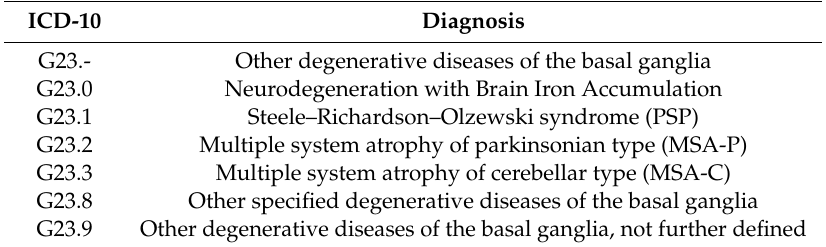
Table 1. Overview of G23.- category and corresponding codes according to the national German DRG (German Diagnosis-Related Groups) classification